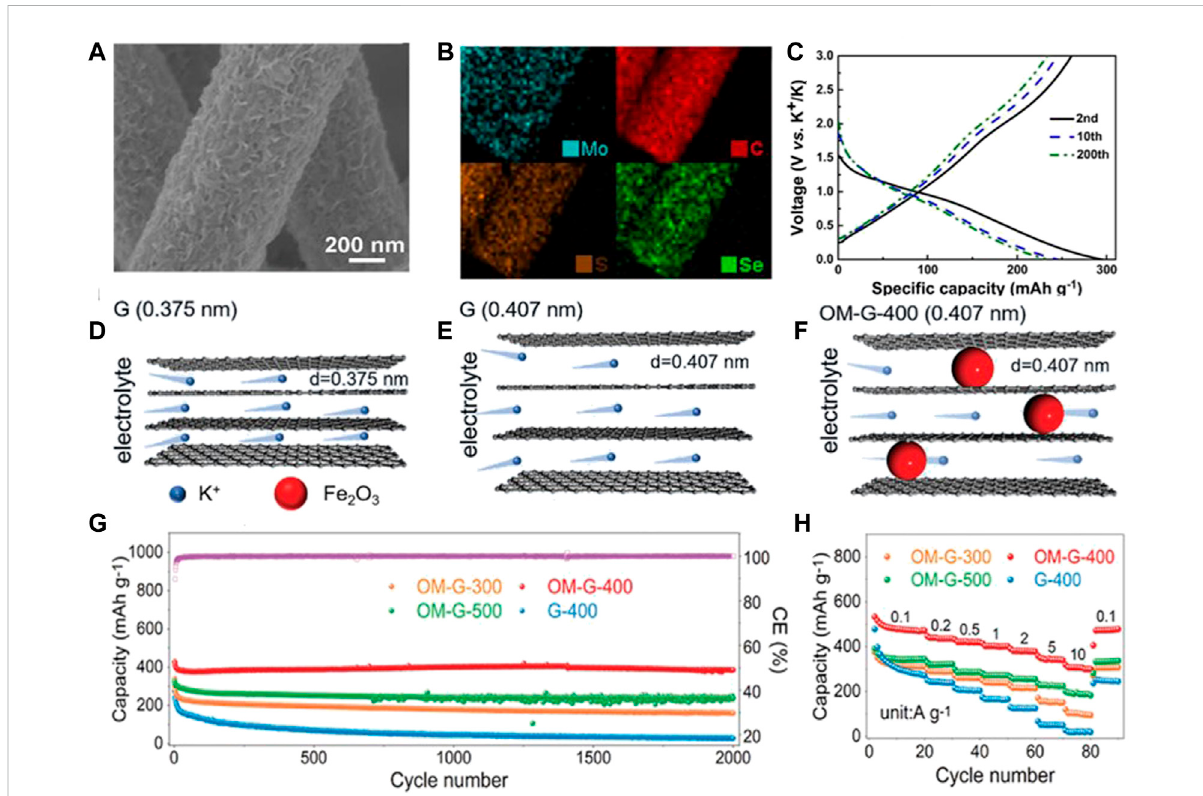
FIGURE 7 (A) SEM and (B) elemental mapping images of v-MoSSe@CM. (C) Second, 10 th , and 200th charge/discharge pro fi les at 0.5 A g − 1 for v-MoSSe@ CM. Reproduced with permission (Tian et al., 2020b). Copyright 2021 Elsevier Ltd. Schematic of K + transport kinetics in (D) G (0.375 nm), (E) G (0.407 nm), and (F) OM-G-400 (0.407 nm) anodes at different discharging times. (G) Cycling performance of 2,000 cycles at 1 A g − 1 and (H) rate performance for OM-G and G-400 anodes. Reproduced with permission (Qiao et al., 2021). Copyright 2021